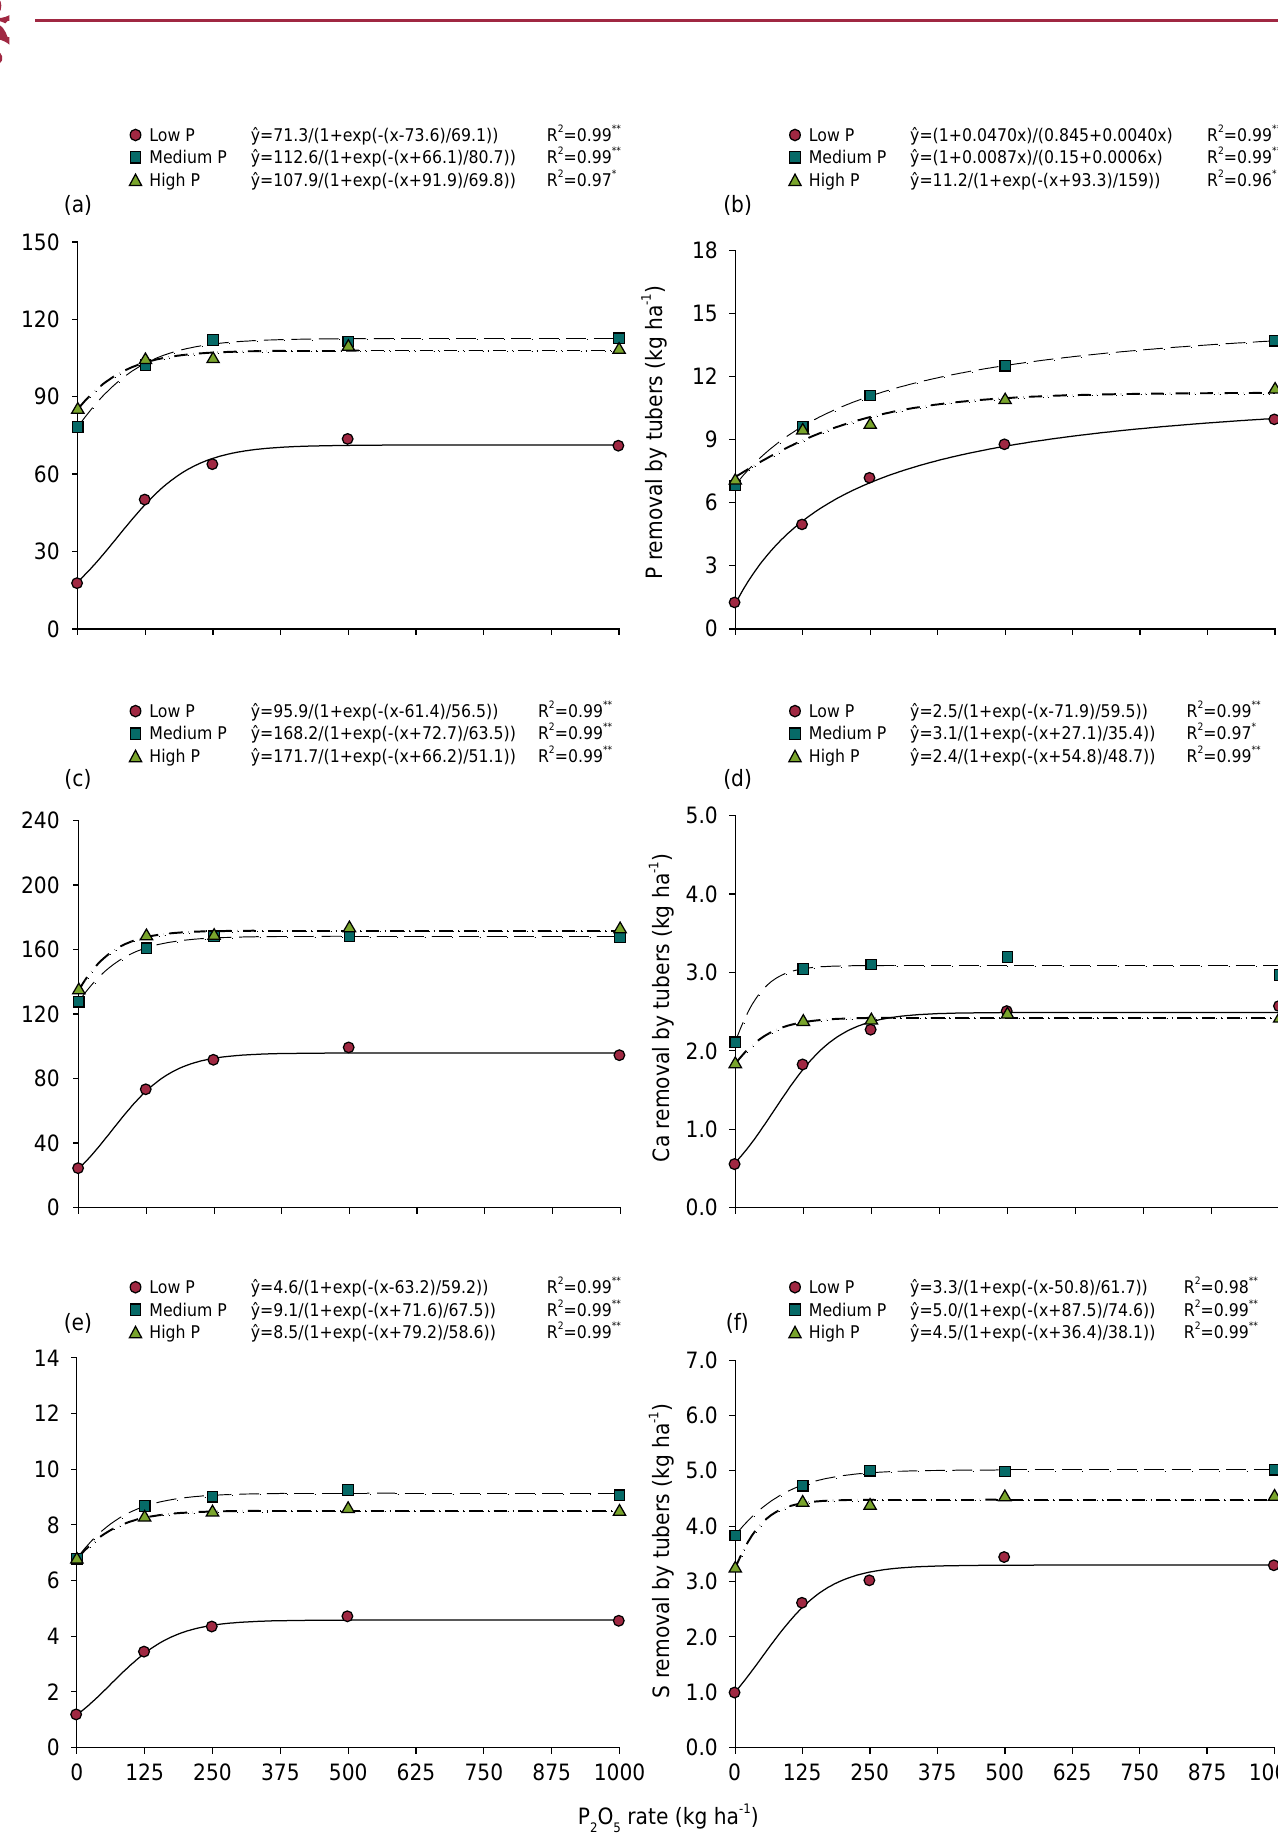
Figure 6. Removal of N (a), P (b), K (c), Ca (d), Mg (e), and S (f) by potato tubers as affected by rates of P applied in the planting furrow in soils with low, medium, and high P availability. Means of five cultivars. * and ** : significant at 5 and 1 % by the F